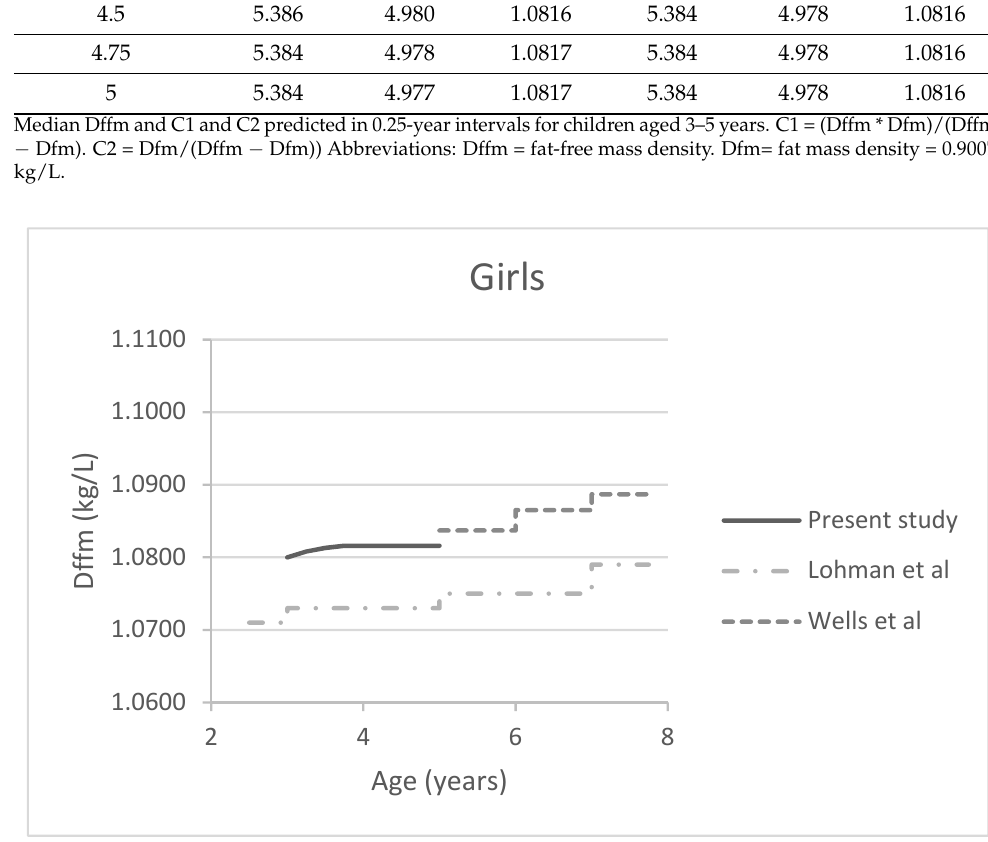
Figure 1. Bland – Altman plots for FM, FM%, and FFM measured by ADP and DXA in full-term ( A – C ) and very preterm-born children ( D – F ) aged 3–5 years: Continuous line represents the mean dif- ference between ADP and DXA. The dashed lines represent the limits of agreement. Abbreviations: